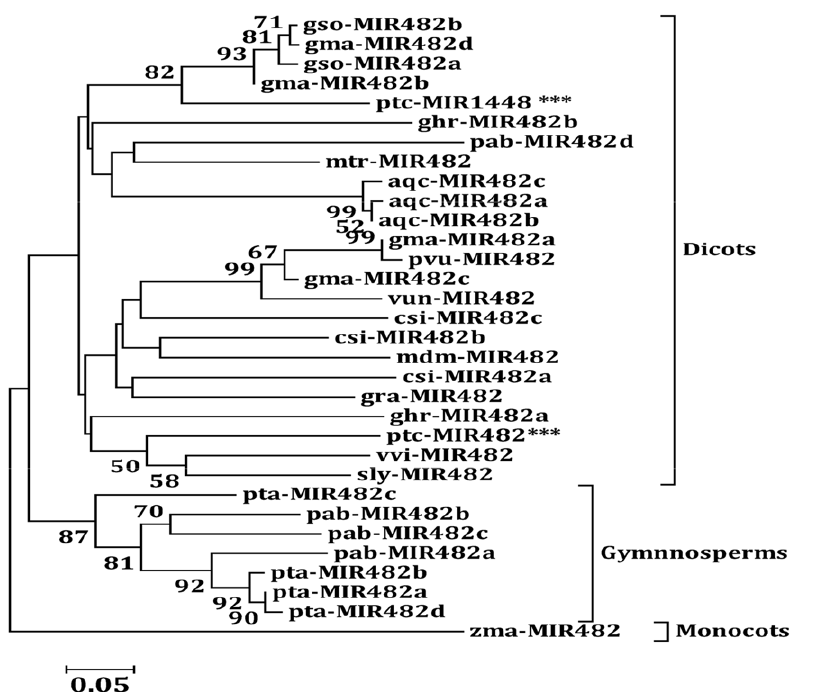
Figure 1. Neighbor-joining phylogenetic tree of pre-miR482 sequences in seed plants obtained from MEGA 5.0. Numbers in the tree represent the bootstrap value (bootstrap values below 50% are not shown at the nodes). The phylogeny of pre-miR1448 of P. trichocarpa is also compared to pre-miR482 sequences in other plants.